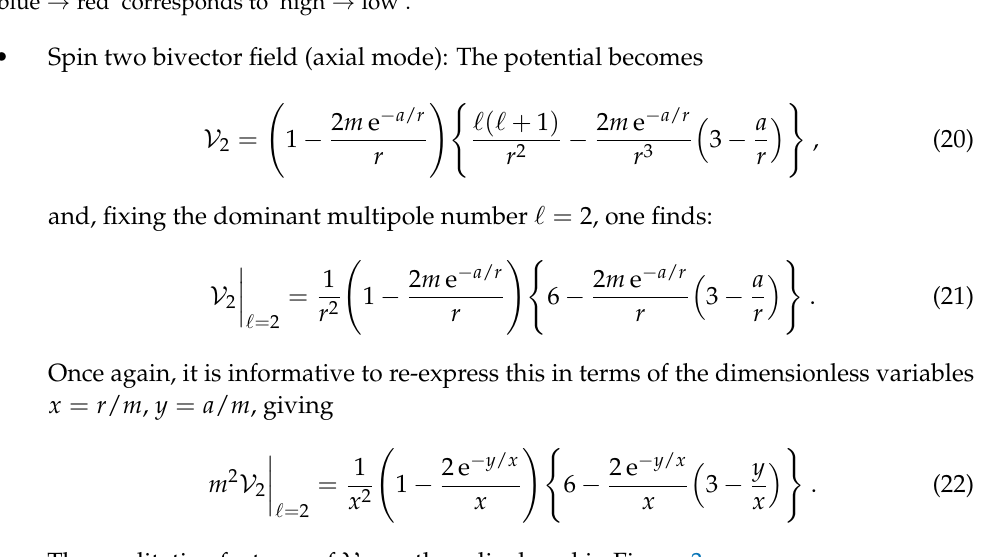
Figure 2. The qualitative features of the spin zero Regge–Wheeler potential for the dominant multipole number (cid:96) = 0 are depicted. ( a ) Three-dimensional plot of m 2 V 0 . ( b ) Contour plot. ‘blue’ → ‘red’ corresponds to ‘high’ →